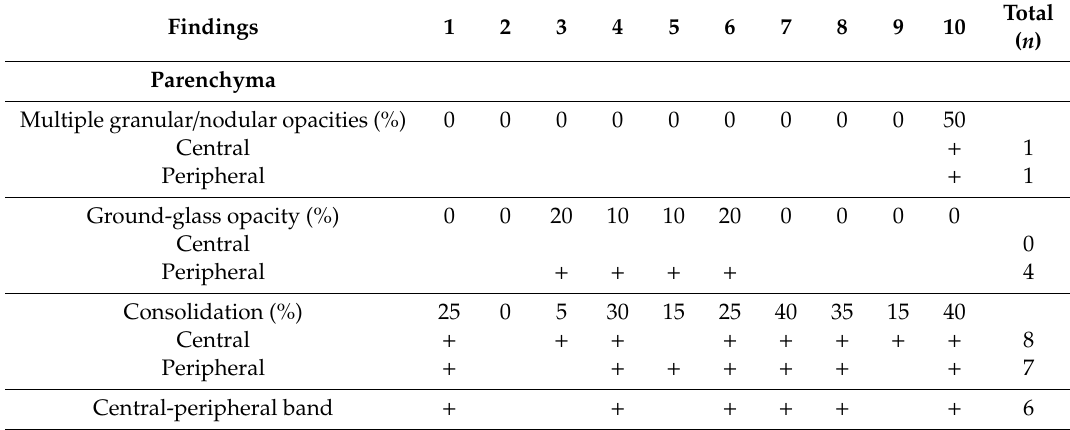
Table 3. CT findings at the time of oxygen therapy induction ( n =